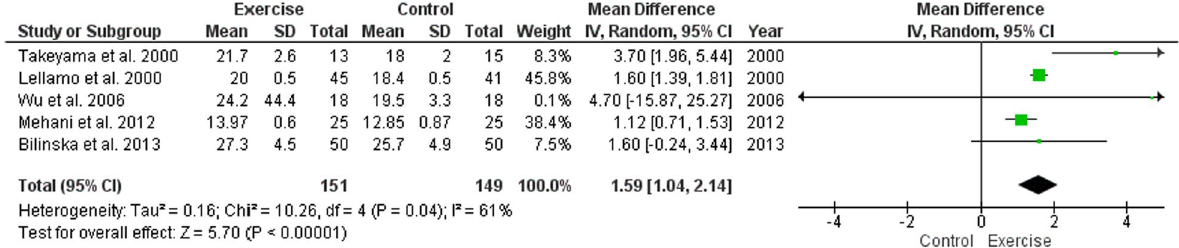
HRV Heart rate variability, RMSSD Square root of the mean squared differences between adjacent RR intervals, LF Low frequency, HFnu High frequency normalize units, LF/HF Ratio of low and high frequency, SDNN Standard deviation of the RR intervals